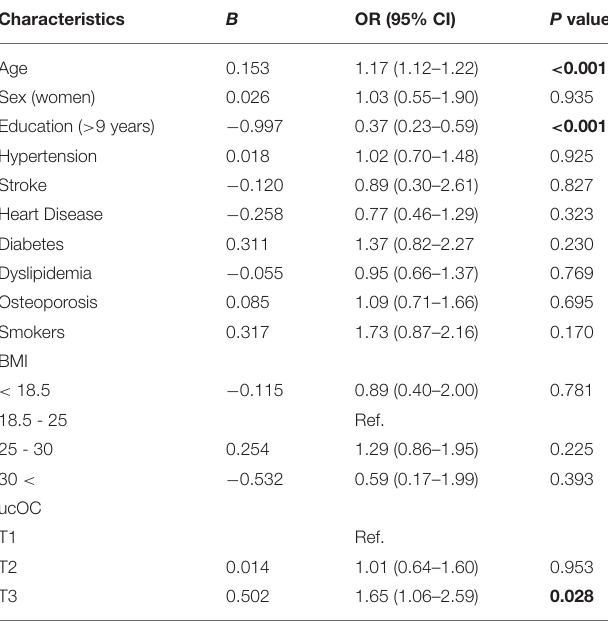
TABLE 2 | Association of characteristics with cognitive impairment. TABLE 3 | Associations between ucOC and categories of cognitive